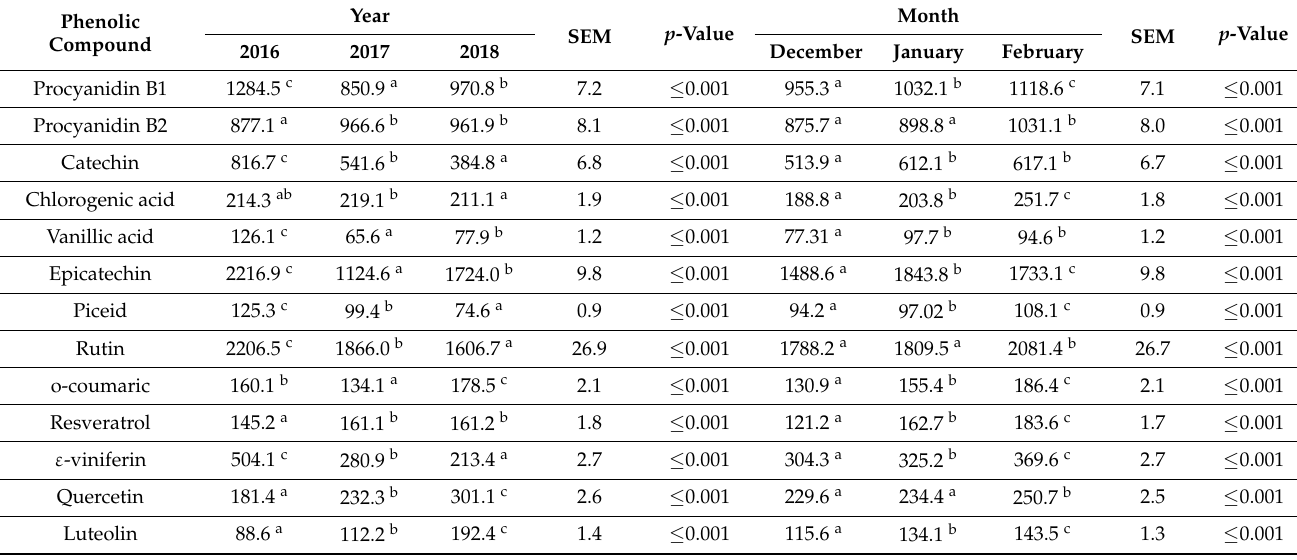
Table 1. Variation of individual phenolic compounds in the latent buds at eco-dormancy in relation to the year and month the applications were carried